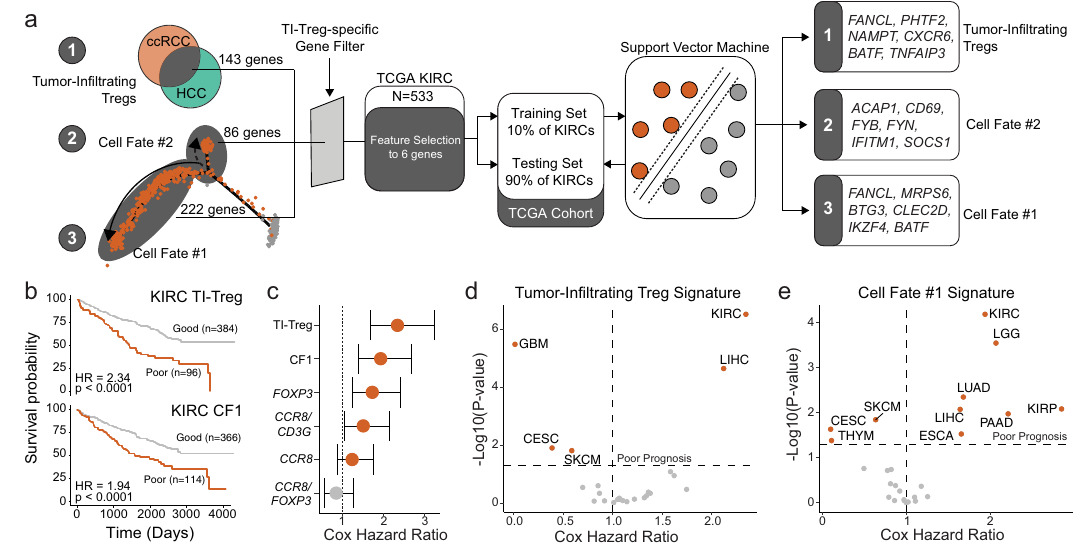
Fig. 3 Improved prognostic prediction is associated with a signature from the suppressive TI Treg cell fate. a Schematic of signature development using feature selection from: (1) 143 common differential genes of TI Treg in ccRCC and HCC, (2) 86 genes differentially expressed in CF2, and (3) 222 genes differentially expressed in CF1 using the 10% of the TCGA KIRC/ccRCC dataset for feature selection. Gene signatures generated after feature selection were used to predict prognosis in the remaining 90% TCGA KIRC/ccRCC, as well as 23 other TCGA cancer datasets. b Kaplan – Meier curves for overall survival in TCGA KIRC/ccRCC using the TI-Treg common gene signature (upper panel) and CF1-Treg gene signature (lower panel). c Prognostic prediction for Treg signatures compared to other proposed signatures for TI Treg cells. Hazard ratios with the bars representing the 95% con fi dence intervals, and P values derived from Cox proportional hazard regression modeling. d , e Overall survival prediction with Cox proportional hazard ratio and − log10( P value) based on two-sided log-rank testing across the 24 largest TCGA datasets using d the TI Treg signature and e the CF1 signature. CESC, Cervical squamous cell carcinoma and endocervical adenocarcinoma; ESCA, esophageal carcinoma; GBM, glioblastoma multiforme; KIRC, kidney renal clear cell